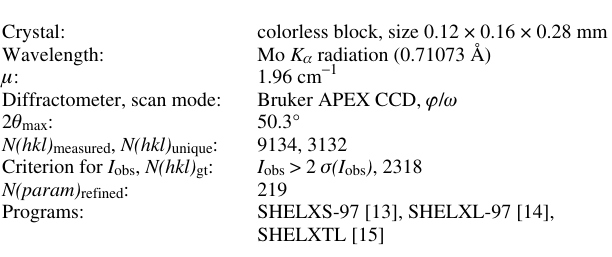
Table 1. Data collection and